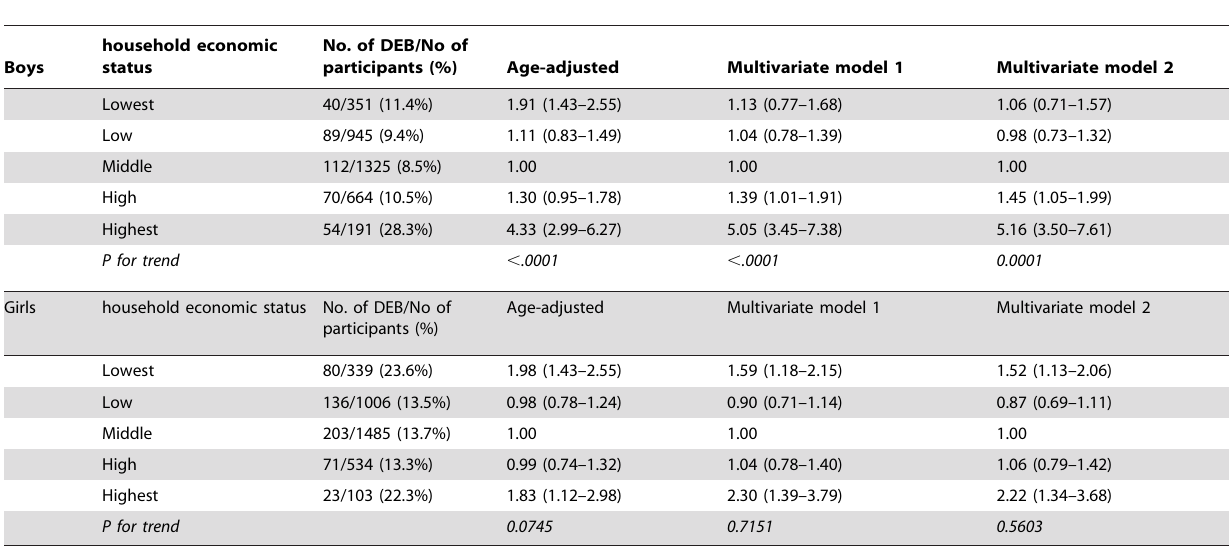
Table 2. Associations between Socioeconomic Status and Disturbed Eating Behavior (DEB) in Korean adolescents by